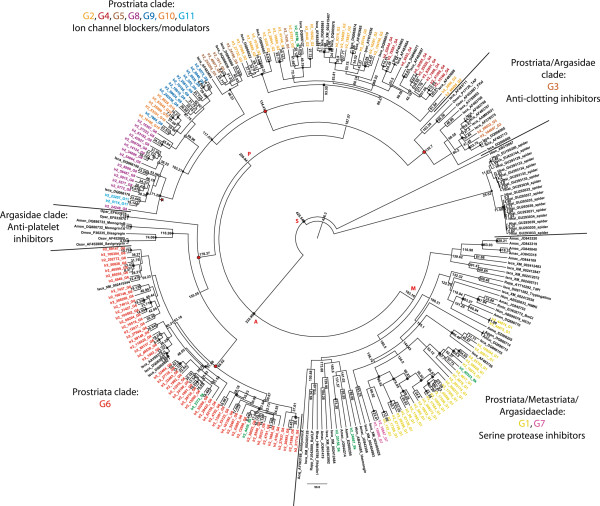
Molecular clock analysis of I. ricinus Kunitz peptides. Kunitz nucleotide sequences of I. ricinus groups (G1-G11 and SK) and of ticks and spiders (defined by GenBank accession numbers) were used to infer divergence times within ticks by a Bayesian uncorrelated relaxed lognormal molecular clock model. Four taxon sets were calibrated according to Jeyaprakash and Hoy [63] and the nodes with the recovered divergence times were labeled: Araneae/Scorpions/Pycnogonida/Acari 459±18 MYA (node S), Argasidae 214±28 MYA (node A), Prostriata 196±27 MYA (node P) and Metastriata 134±22 MYA (node M). The figure shows a maximum clade credibility tree including the mean divergence times (MYA) at each node. Well supported nodes and matching ML and Bayesian analyses (bootstrap values ≥70%, posterior probabilities ≥0.7, see Additional file 4) are indicated with black circles. Nodes with gray circles appeared in the ML and Bayesian trees, but they were not well supported (bootstrap values ≤70% and posterior probabilities ≤0.7). Black squares indicate well supported nodes by the Bayesian analysis (posterior probabilities ≥0.7), but were not resolved in the ML tree. Gray squares indicate well supported Bayesian tree nodes (posterior probabilities ≥0.7) that were less supported in the ML analysis (bootstrap values ≤70%). Non-labeled nodes were not well supported in both analyses (bootstrap values ≤70% and posterior probabilities ≤0.7) and they did not match in both phylogenetic reconstructions. The four best-supported clades (supported well by both analytical methods) are labeled with red circles at the nodes. The red star at the node highlights a clade containing G8 and G11 members at a divergence time of 71 MYA that is similar to the divergence time of G6. The scale bar in MYA is at the bottom center of the tree.